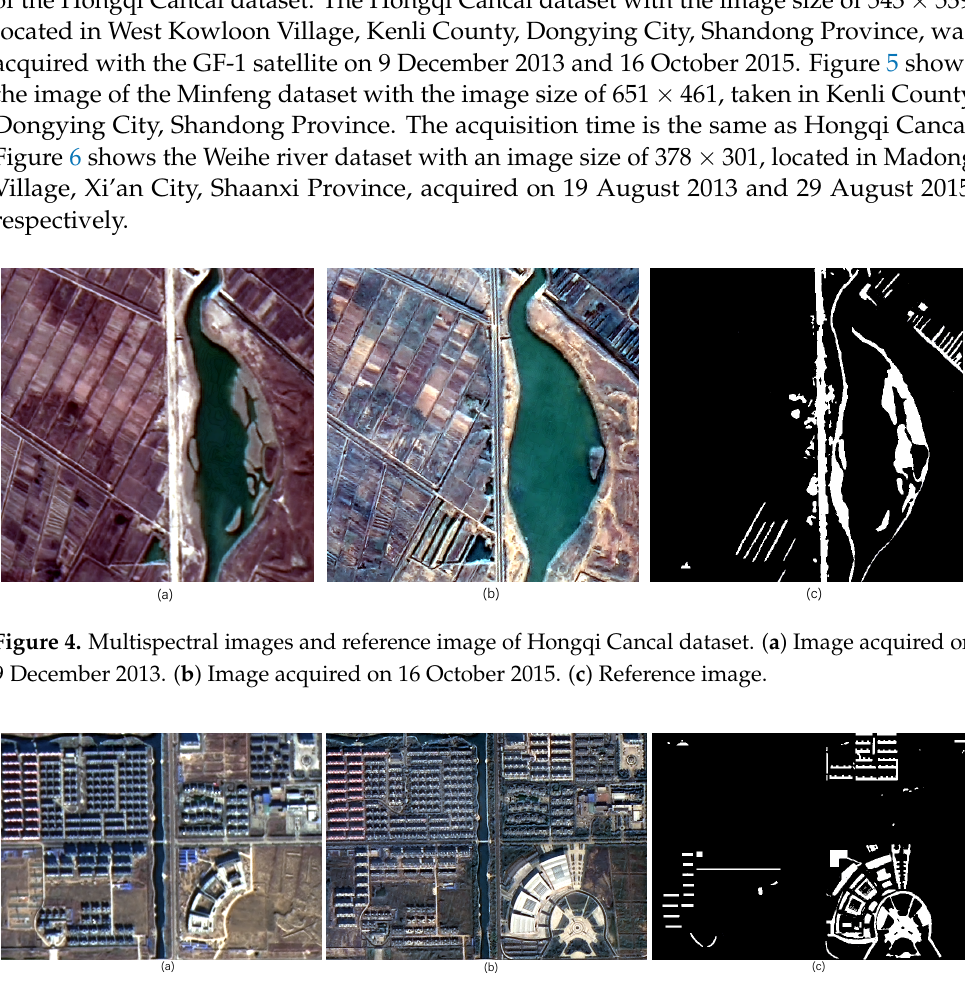
Figure 5. Multispectral images and reference image of Minfeng dataset. ( a ) Image acquired on 9 December 2013. ( b ) Image acquired on 16 October 2015. ( c ) Reference image.